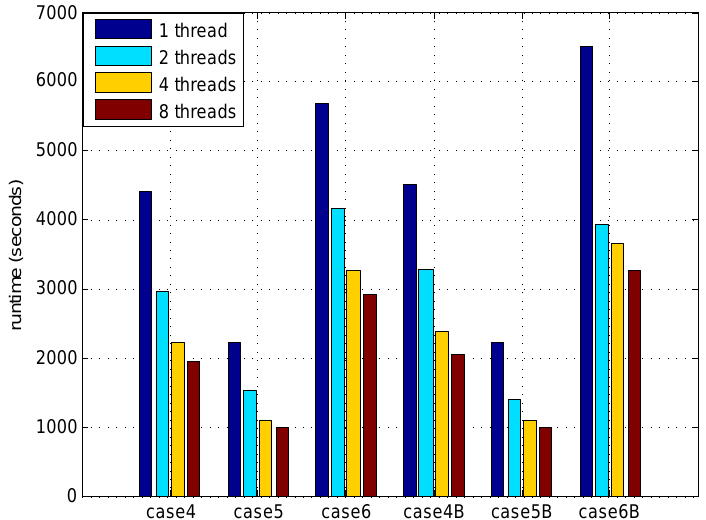
Figure 9. Runtime comparison among 1, 2, 4 and 8 threads.